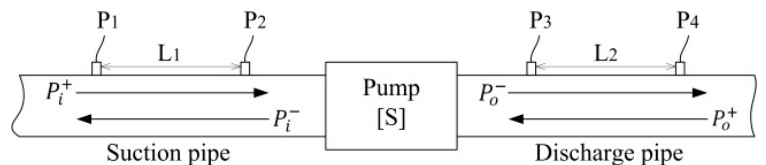
Figure 3. Acoustic system of the composition of the pump and pipeline.